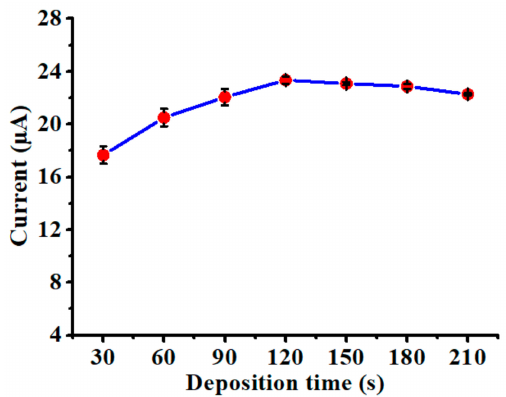
Figure 6. Influence of deposition time on the stripping peak current of the nanoparticles-modified chemical sensor in the solution of 20 µ g/L Cd(II) with 0.1 M acetate buffer, where deposition potential is − 1.0 V. Data are presented as the mean of three replicates and error bars denote the standard